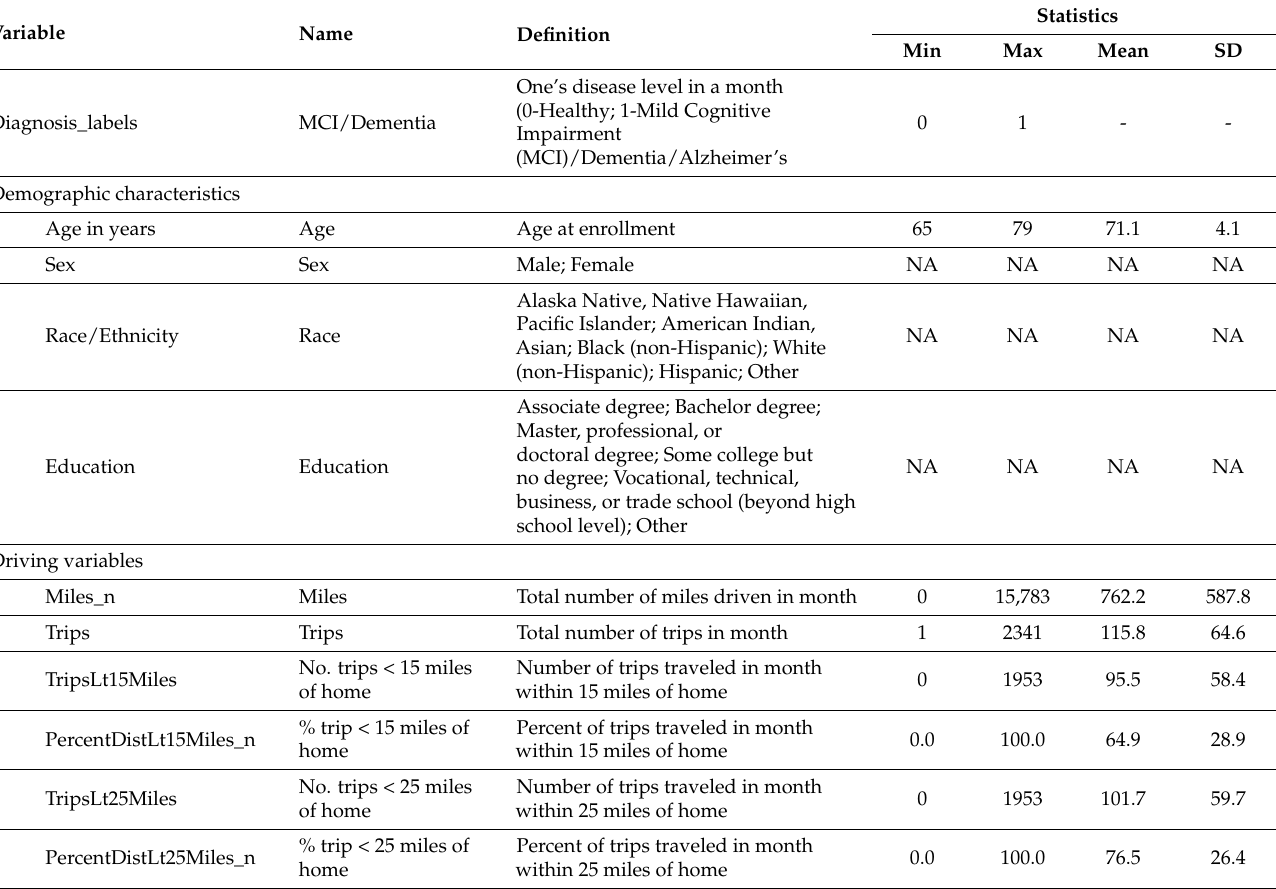
Table 1. Variable definitions and